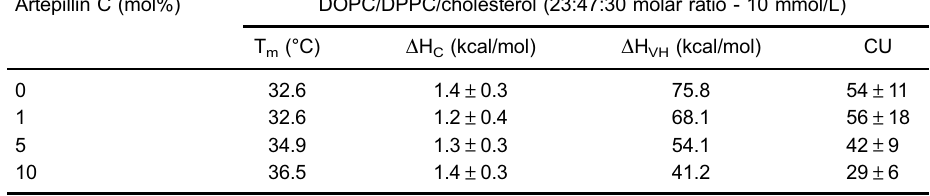
Data are reported as mean ± SD. T m : transition temperature; D H C : transition enthalpy; D H VH : van ’ t Hoff enthalpy; CU: cooperative